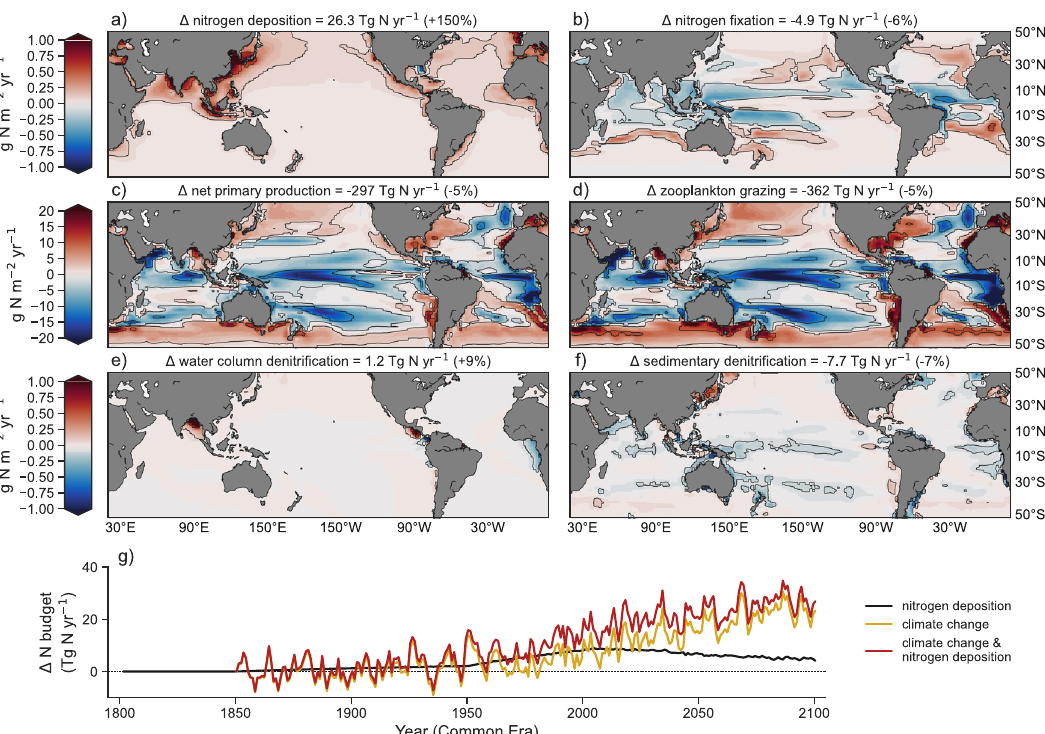
Fig. 1 Anthropogenic perturbation ( Δ ) of the marine nitrogen cycle by 2081 – 2100. Change is relative to the preindustrial control simulation. Top row shows major sources: a nitrogen deposition; b nitrogen fi xation. Upper middle row shows internal cycling: c net primary production; d zooplankton grazing. Lower middle row shows major sinks: e water column denitri fi cation; f sedimentary denitri fi cation. Burial of nitrogen in sediments is not shown. Globally integrated changes are shown above each panel. Note the different scale for internal cycling. g Change in global nitrogen budget (sources minus sinks) due to anthropogenic